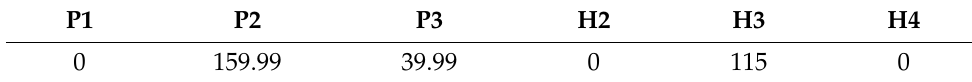
Table 4. Optimal schedule for the best cost obtained for Case study 1.